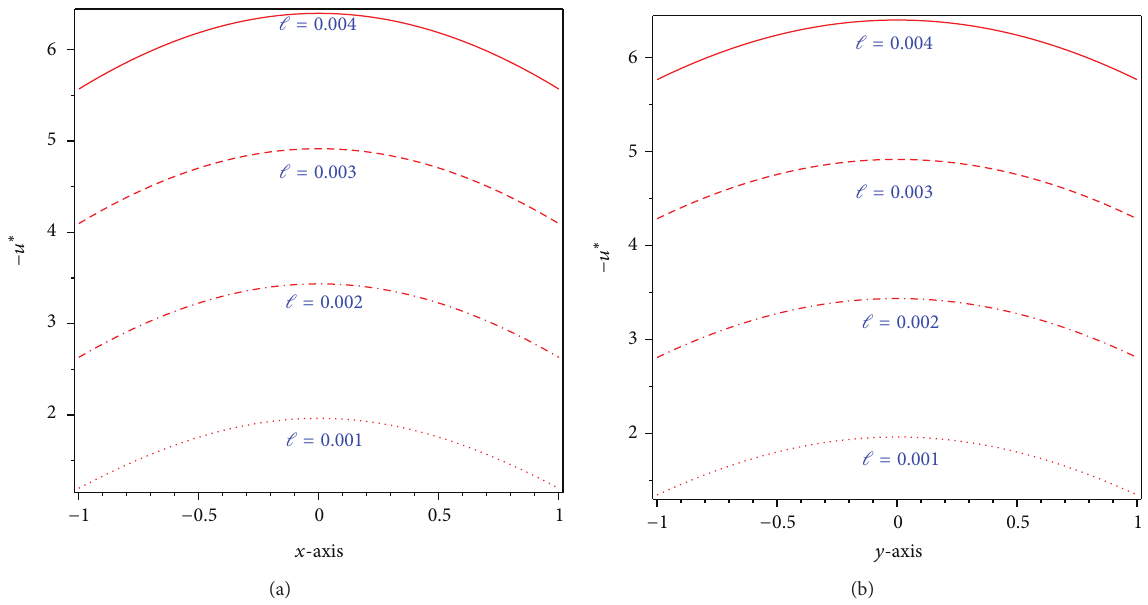
Figure 4: 2D velocity profile along the 𝑥 -axis and 𝑦 -axis on the cross-section of the channel with the area of 1.0 × 10 −6 m 2 and ratio 𝜀 of 3/4 for constant pressure gradient under different slip lengths ℓ values.